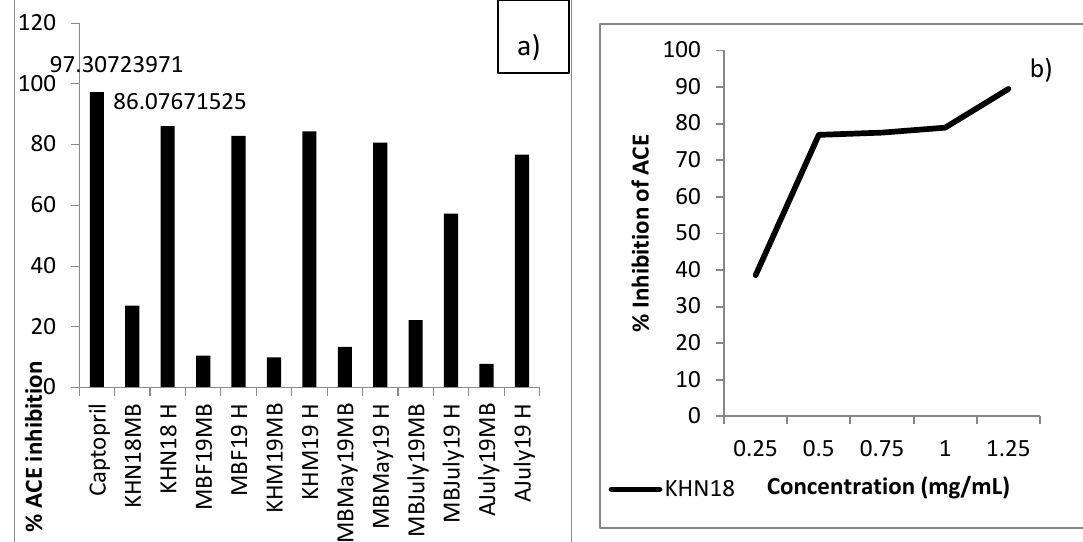
Figure 9. ( a ) The % ACE-I enzyme inhibition (%) by mussel Protamex ® hydrolysates. Six representative unhydrolyzed mussle broth samples (MB) and corresponding hydrolysates (H) from the three sampling sites, Mulroy bay (MB), Killary harbor (KH) and Ardgroom (A), collected from November 2018 to July 2019, were used for analysis at a concentration of 1 mg / mL against captopril (the positive control). ( b ) The IC 50 curve for the Killary harbour November 2018 sample (KHN18). The positive control showed significantly higher ACE inhibition as compared to all the samples and all the hydrolysates showed significantly higher ACE inhibition as compared to unhydrolyzed samples. Assays were performed in triplicate (n = 3).